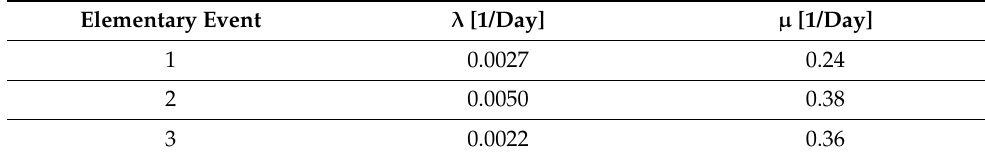
Figure 1. Example of fault tree. Table 2. Assumed values of µ and λ for elementary events.